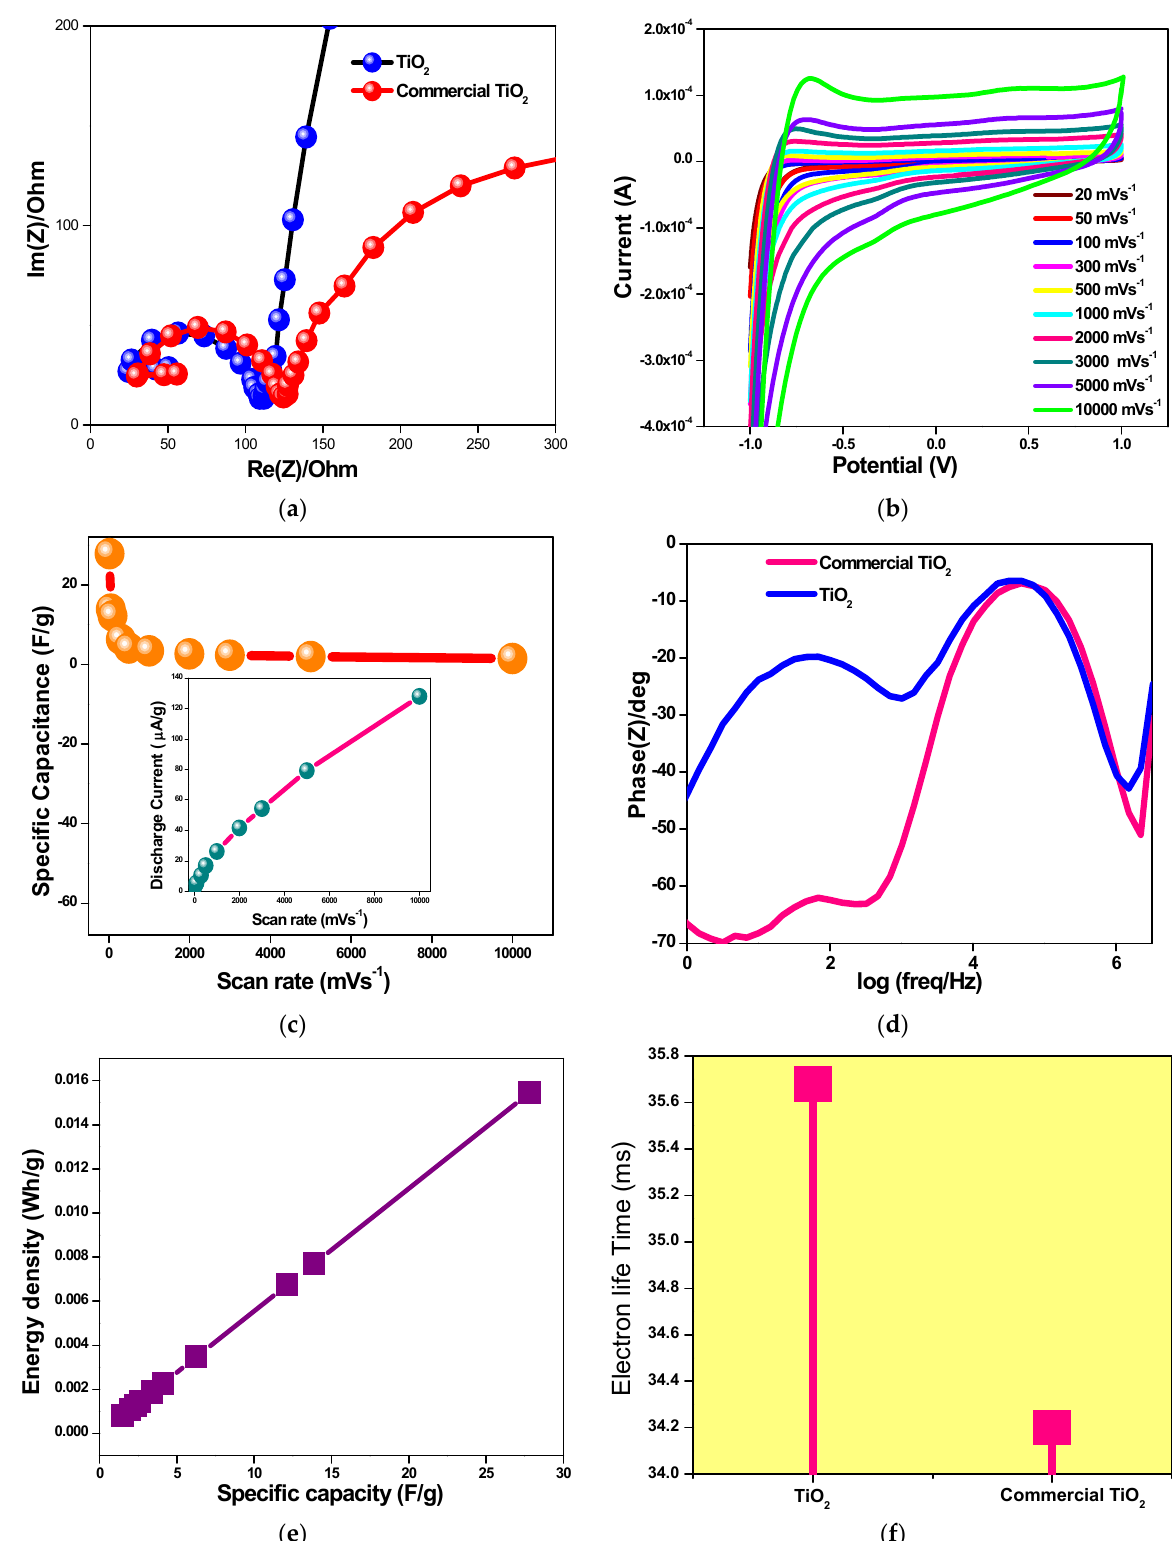
Figure 8. ( a ) Nyquist impedances; ( b ) CV at various scan rates; ( c ) variation of specific capacitance (inset, discharge currents) with scan rates; ( d ) Bode plot; ( e ) variation of energy density vs. scan rates; ( f ) electron lifetime plot.